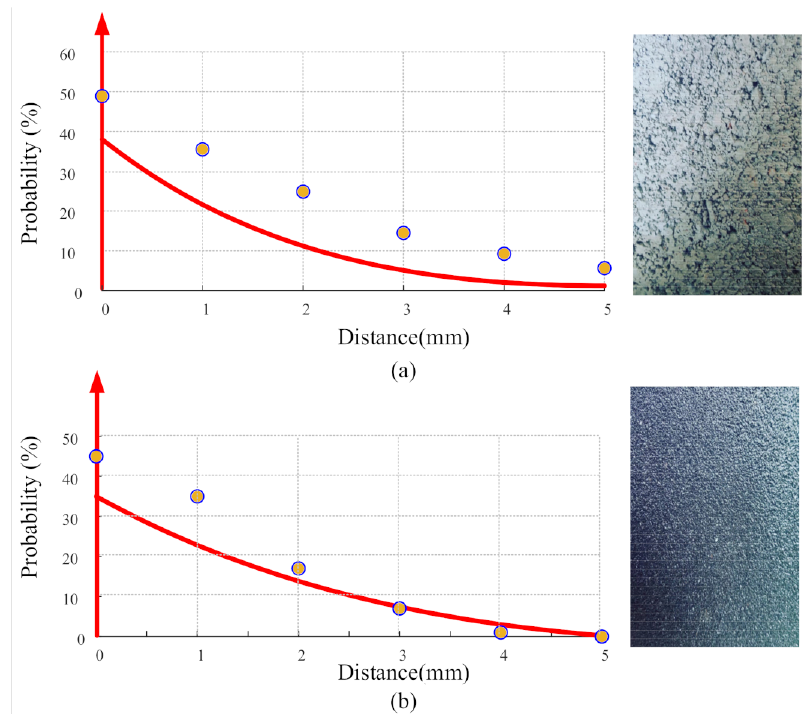
Figure 5. Experimental results and prediction curves. ( a ) The microspine travels on the surface of the brick, α = 0.62, λ = 0.2. ( b ) the microspine travels on sandpaper, α = 0.65, λ =